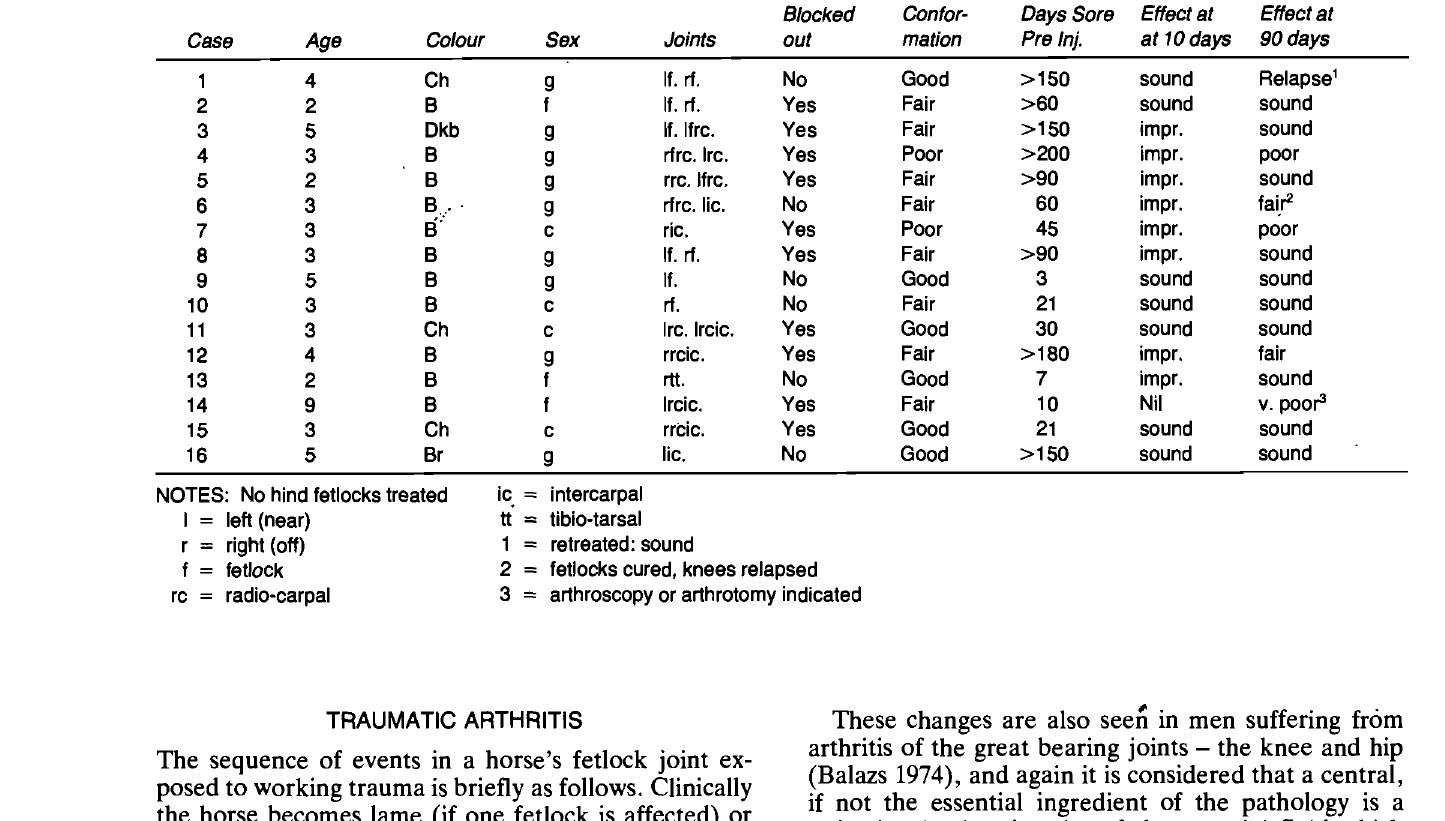
Table 1: SUMMARY OF PATIENTS TREATED BY INTRA-ARTICULAR SODIUM